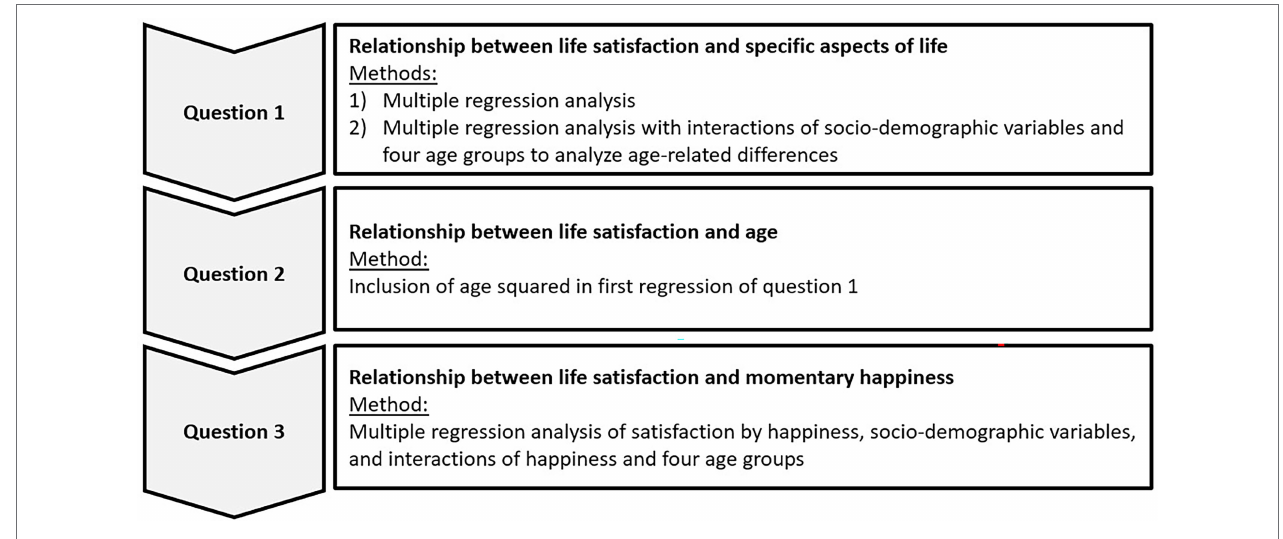
FIGURE 1 | Overview of the research approach.